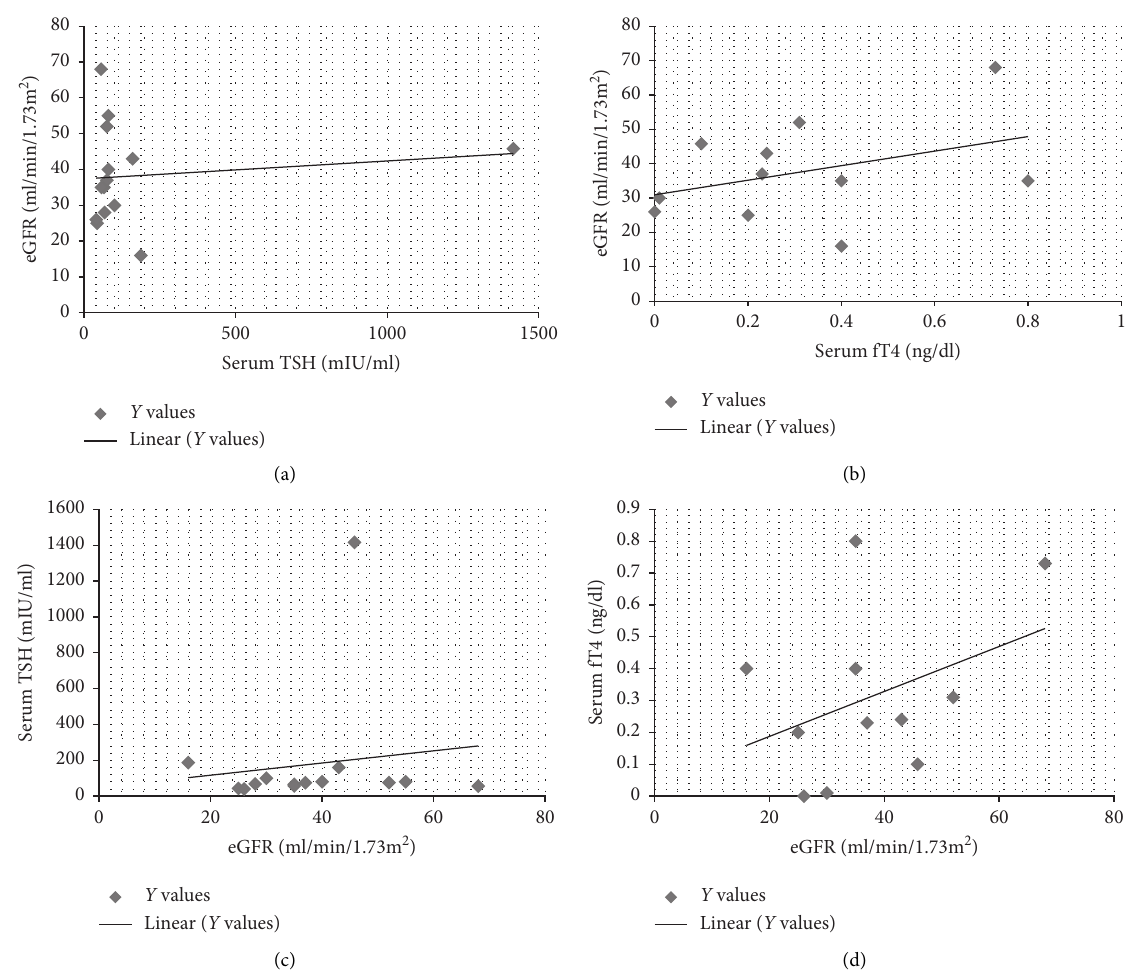
Figure 7: Correlation between serum TSH and fT4 levels with different stages of CKD. a, b. Impact of abnormal TSH and fT4 levels on different stages of CKD in primary hypothyroidism. c, d. Impact of kidney dysfunction on serum TSH and fT4 levels in primary hy- pothyroidism. CKD, chronic kidney disease; fT4, free thyroxin; TSH, thyroid-stimulating hormone.